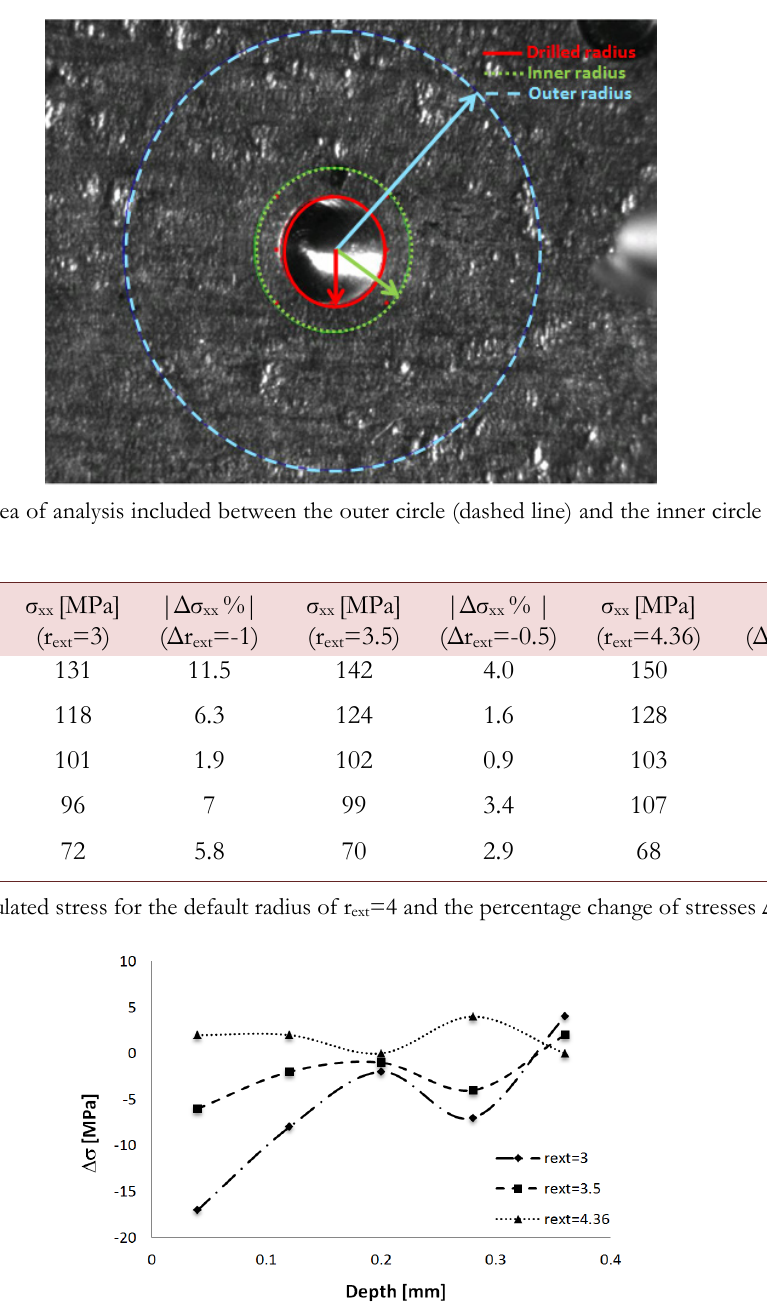
Figure 6: Plot of the difference in terms of measured stress at different depths. The difference are calculated for three different values of the external radius with respect to the reference value r ext